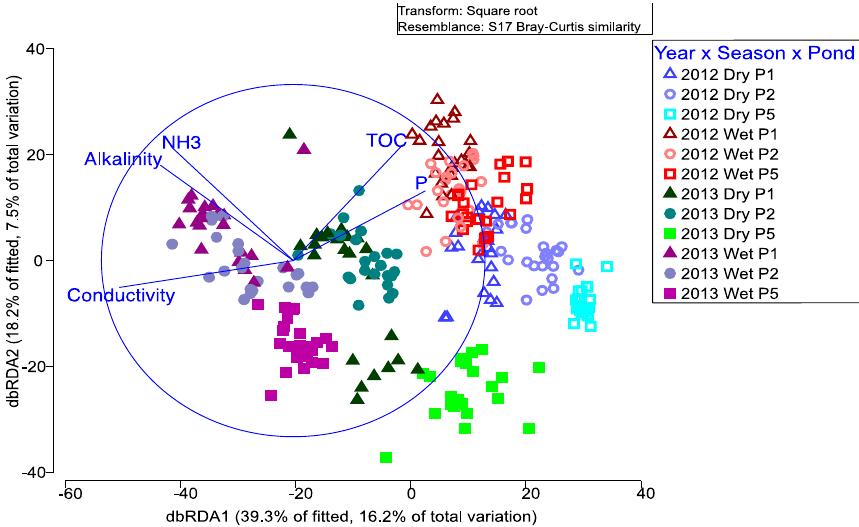
Figure 3. Distance-based redundancy analysis (dbRDA) based on a distance linear model of Sanderson bacterial communities and the physico-chemical environment. Dry = dry season, Wet = wet season, P1 = Pond 1, P2 = Pond 2 and P5 = Pond 5.